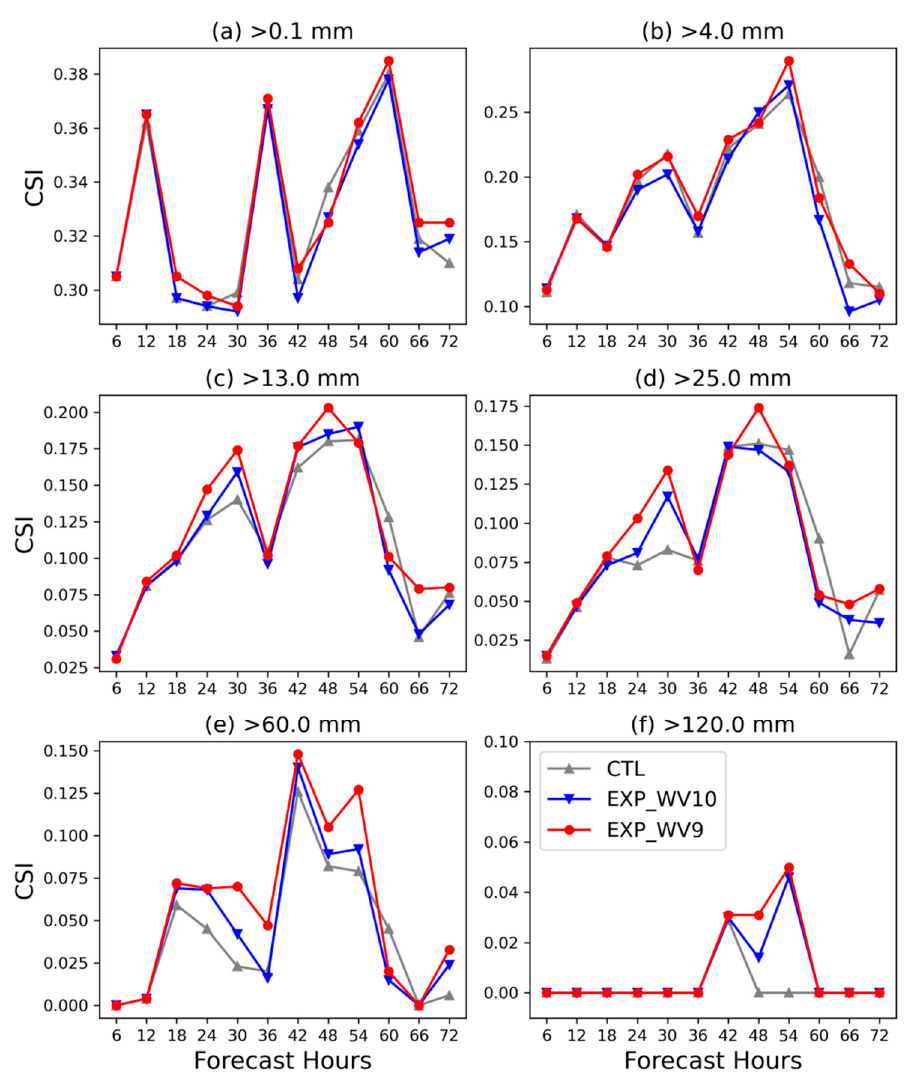
Figure 18. The CSI variations of 6 h accumulated precipitation in the 0–72 h forecasts of the CTL (grey), EXP_WV9 (red), and EXP_ WV10 (blue) for different rainfall thresholds with the initial time at 0000 UTC on 19 July 2021.